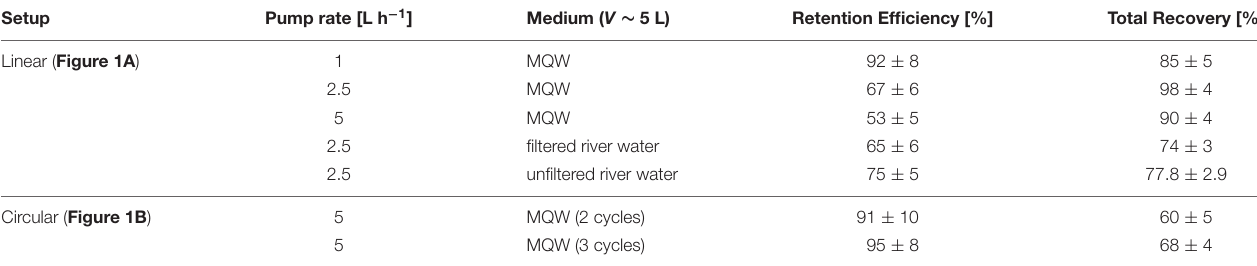
TABLE 1 | Retention efficiencies and recoveries for the Pd-doped NPPs in the different fractions in the different setup using one CFC system (17000 rpm).